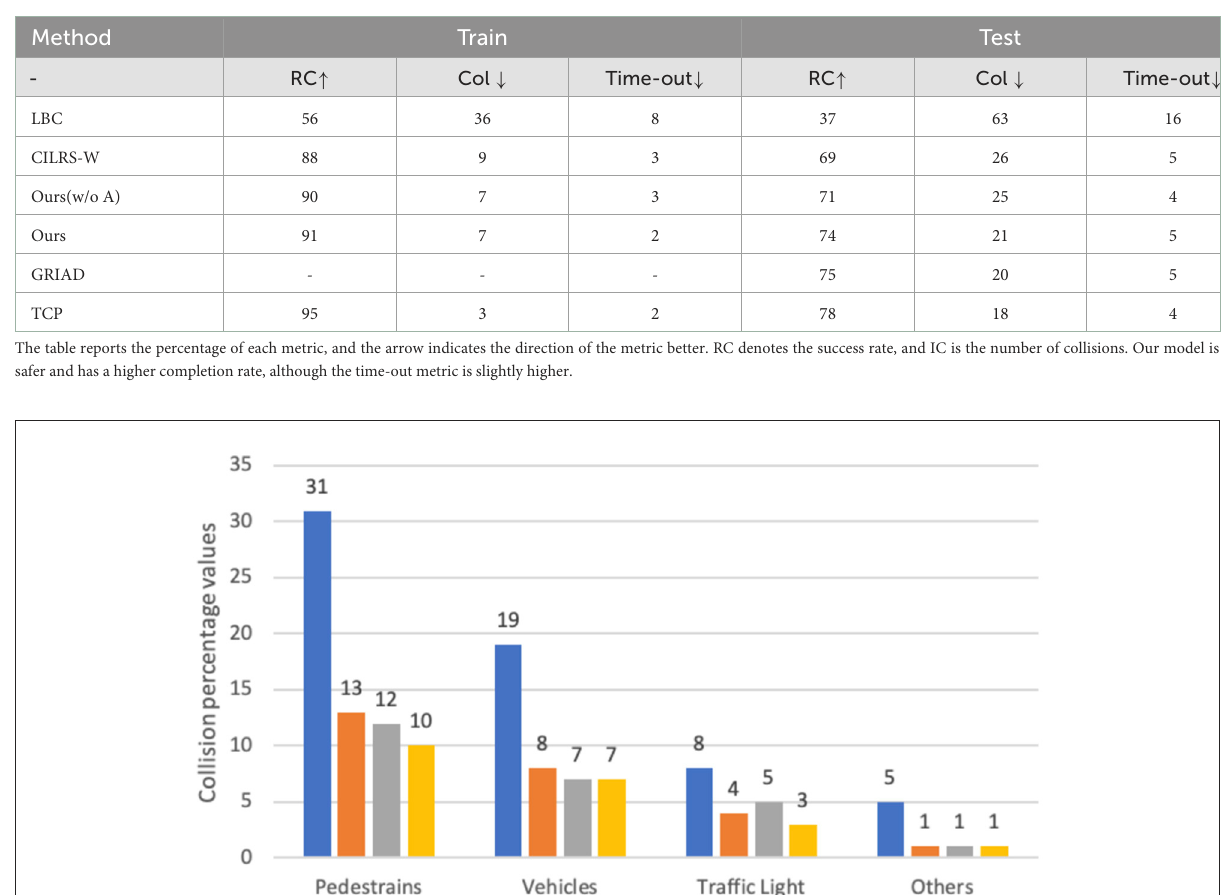
TABLE 2 Model performance comparisons.